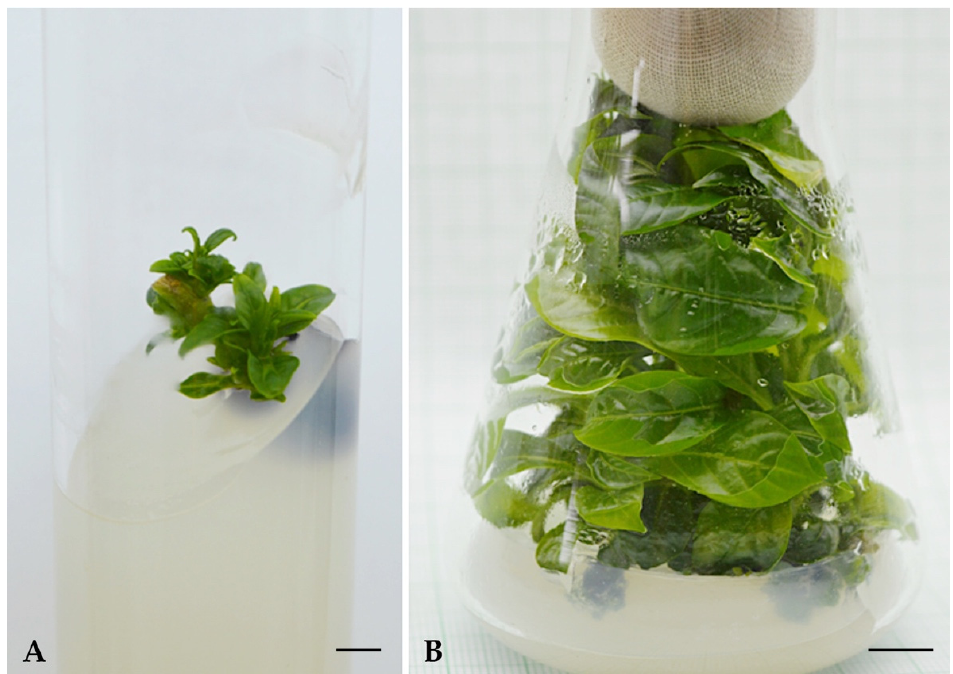
Figure 1. ( A ) Multiple shoot bud induction from node explants of L. speciosa on MS medium supplemented with 5.0 µM TDZ after 4 weeks of culture (Bar = 0.8 cm); ( B ) proliferation of shoots from TDZ-pretreated node explants on MS medium supplemented with 1.0 µM BA + 0.25 µM NAA after 12 weeks of culture (Bar = 1.3 cm). Table 2. Secondary (or narrow) screening of TDZ for multiple shoot induction from node explants of L. speciosa after 4 weeks of incubation.